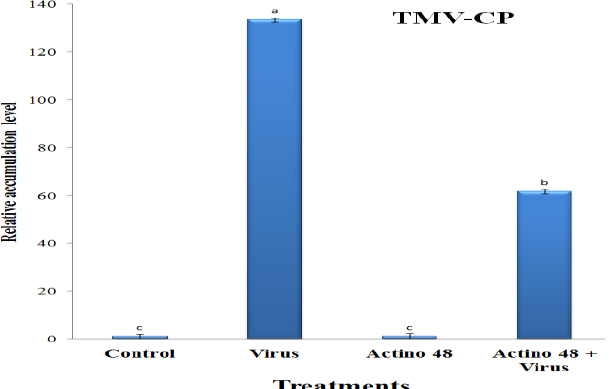
Figure 4. The relative expression level of the TMV-CP (coat protein) gene in TMV-infected tomato plants at 21 days post-inoculation. Columns with the same letter denote insignificant differences.